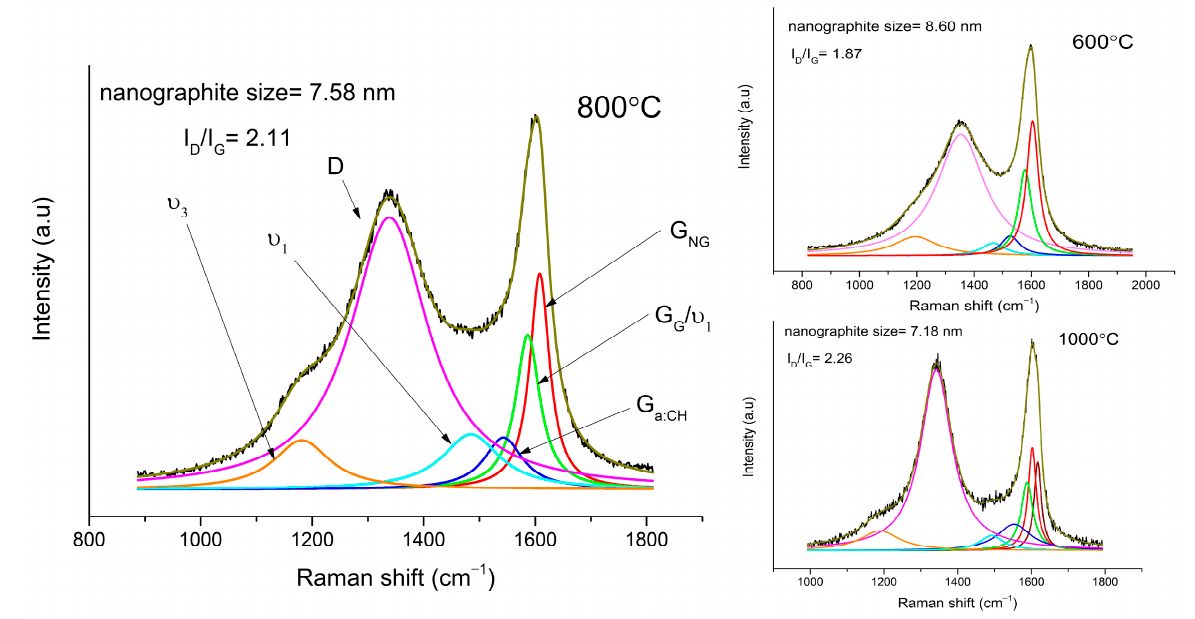
Figure 1. Fitted first—order Raman spectrum of sample sintered at 800 °C, 600 °C, and 1000 °C.